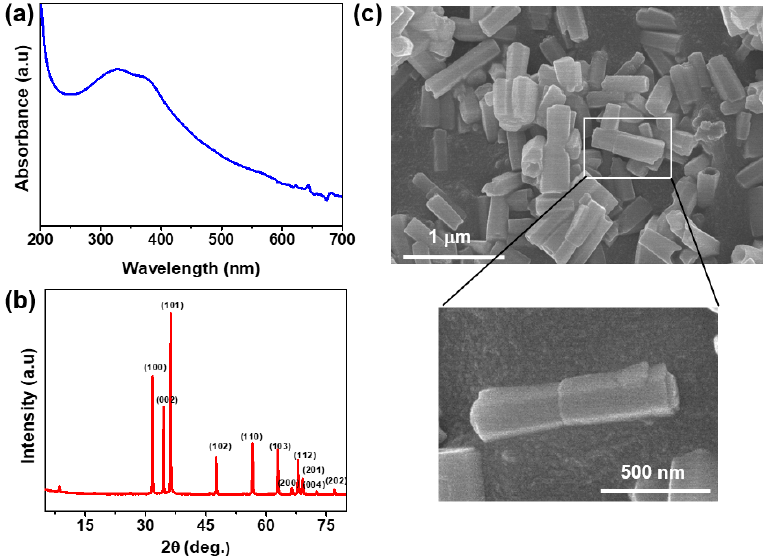
Figure 1. ( a ) UV–Vis spectrum, ( b ) XRD pattern, and ( c ) FESEM image of ZnO nanoparticle